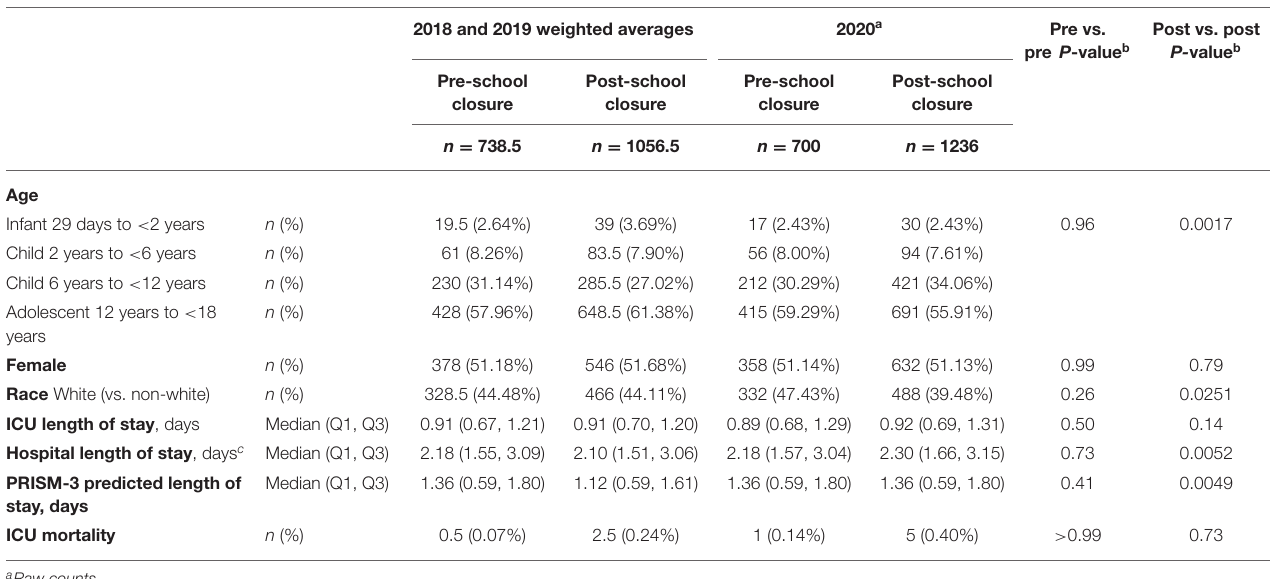
Frontiers in Pediatrics |